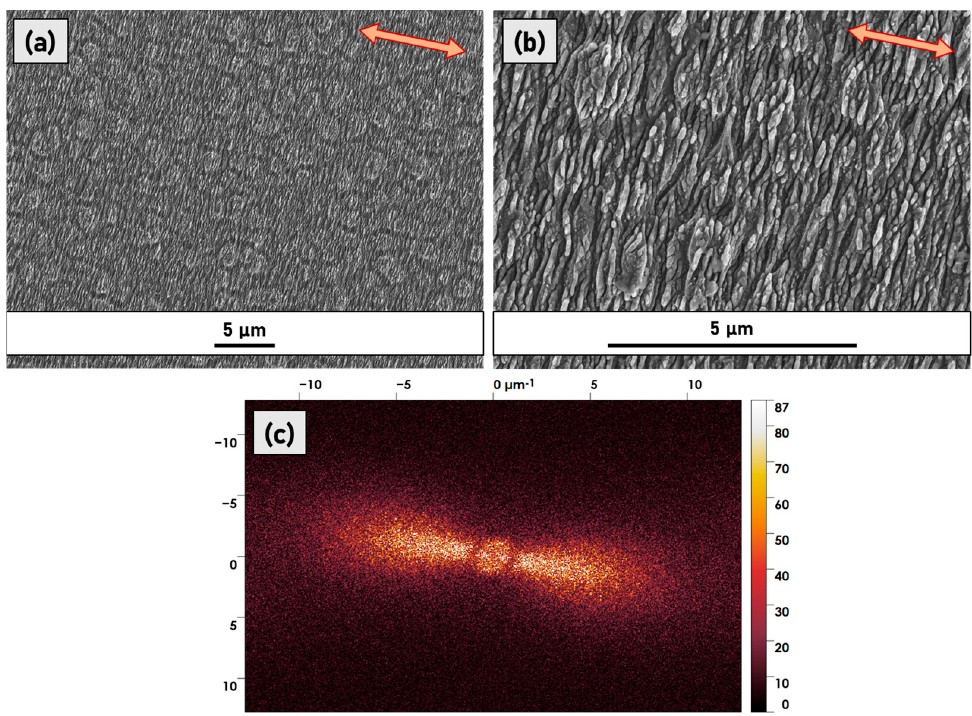
Figure 2. SEM micrographs of sample P5 at ( a ) low magnification and ( b ) high magnification. The red arrows indicate the laser polarisation direction. In ( c ) the 2D − FFT spectrum is shown obtained by analysing the SEM micrograph reported in ( a ).